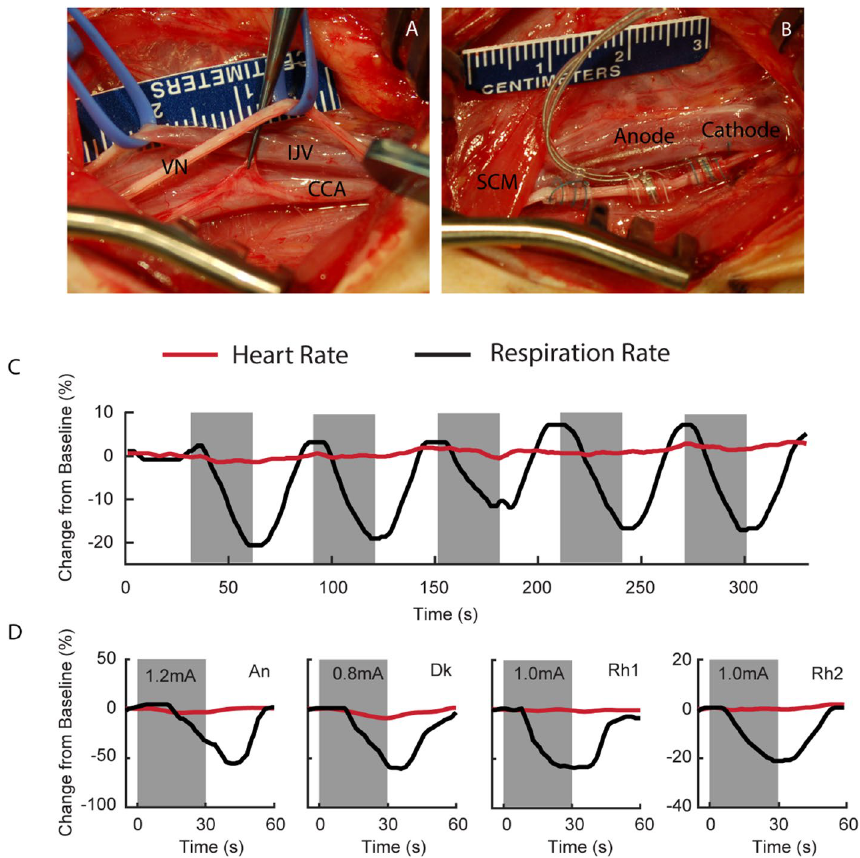
Fig. 1 VNS electrode implantation and intraoperative verification of target engagement. A Surgical field following identification and careful dissection of the carotid sheath exposing the common carotid artery (CCA), internal jugular vein (IJV) and vagus nerve (VN). B Implantation of bipolar stimulation electrode on the vagus nerve with the cathode placed caudally to the anode. Notice the sternocleidomastoid (SCM) crossing the surgical field. C Representative time series of the response of heart rate (red) and respiration rate to VNS. Periods of VNS are represented by gray bars. D Intraoperative VNS was used to verify proper engagement between the VN and stimulating electrode. Average evoked responses for NHPs An, Dk, Rh1 and Rh2 demonstrate that 30 s of VNS (gray bars) evokes a robust, sustained parasympathetic response manifest as a greater than 20% reduction in the rate of respiration (black traces), with no apparent change in heart rate (red